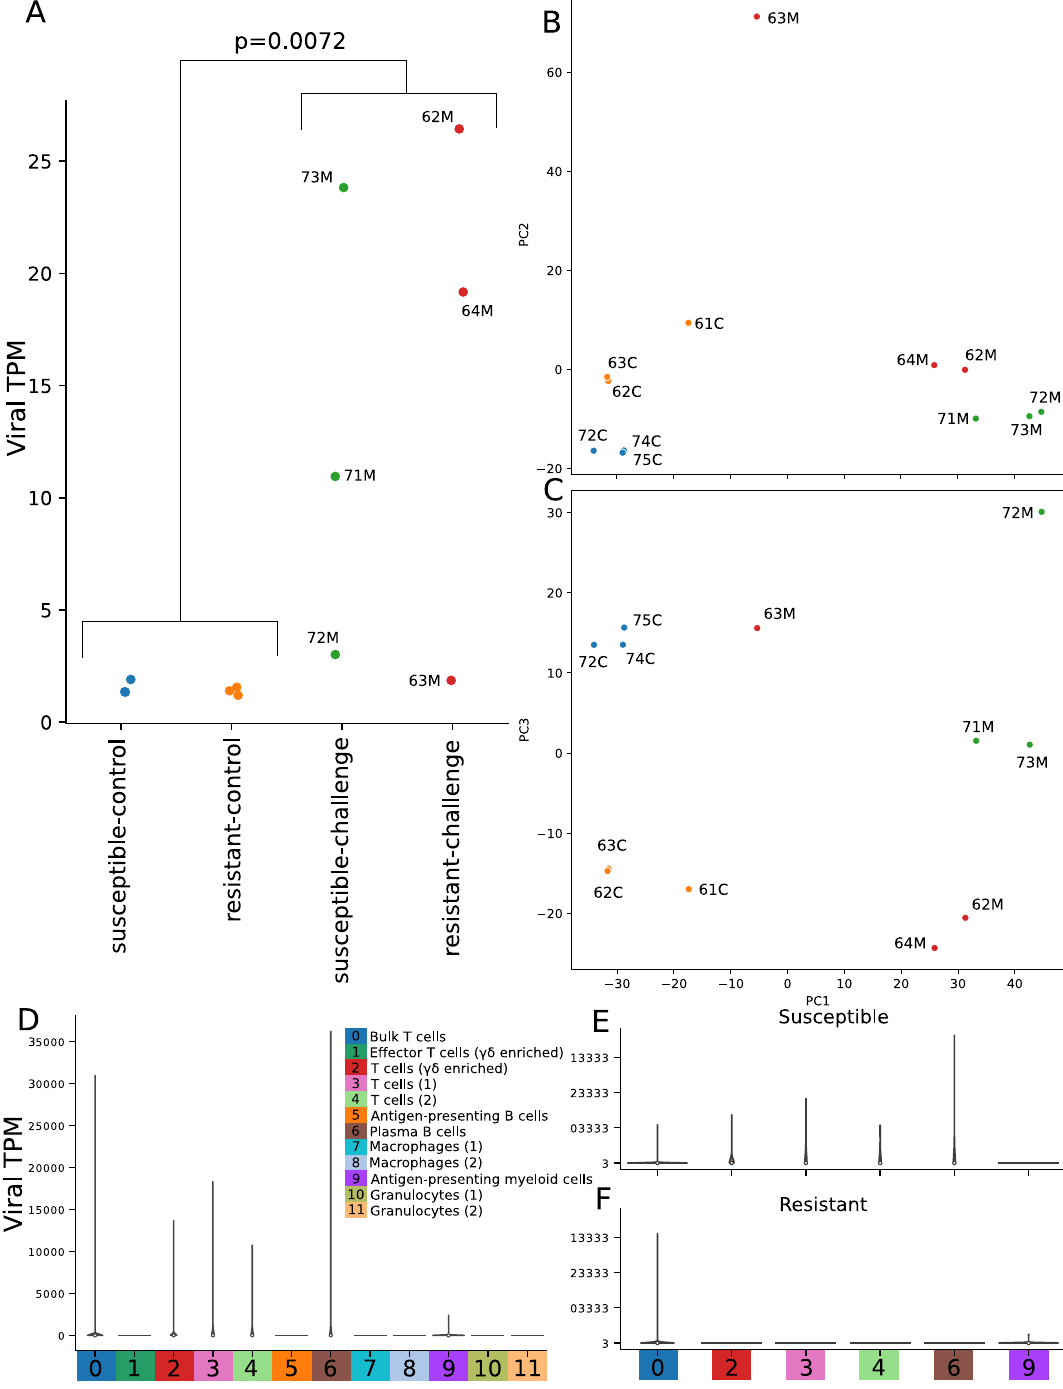
Figure 3. Viral transcription by individual, challenge status, genetic line, and cell type. ( A ) Viral transcripts per million in each library, separated by line and challenge status. Sample names are defined with first digit representing line 6 or 7, second digit representing the biological replicate, and the third character indicating whether the bird was infected with MDV (M) or an uninfected control (C). ( B , C ) Principal component analysis of bulk-collated gene expression data, showing PC1 versus PC2 ( B ) and PC1 versus PC3 ( C ). ( D ) Viral TPM values for each cell, grouped by cluster, shows signs of infection in most T cell clusters, as well as the plasma B and antigen-presenting myeloid clusters. ( E , F ) Viral TPMs for only cells from challenged birds, broken down by line, demonstrate that more clusters in the susceptible line show signs of infection than in the resistant